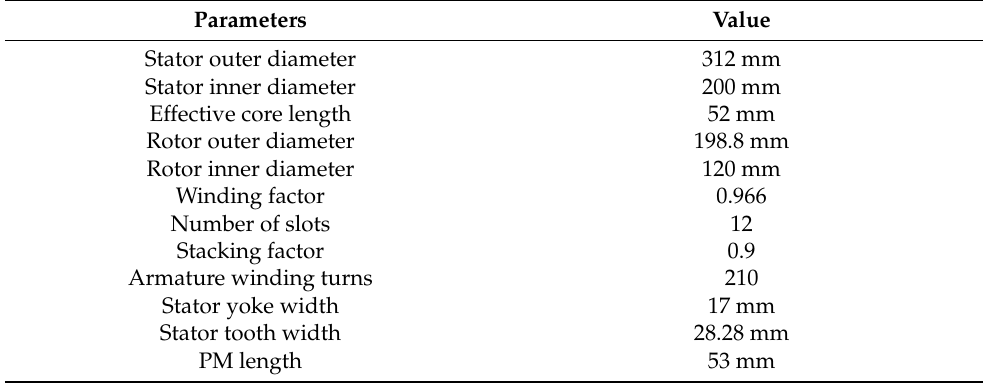
Table 1. Dimension parameters of